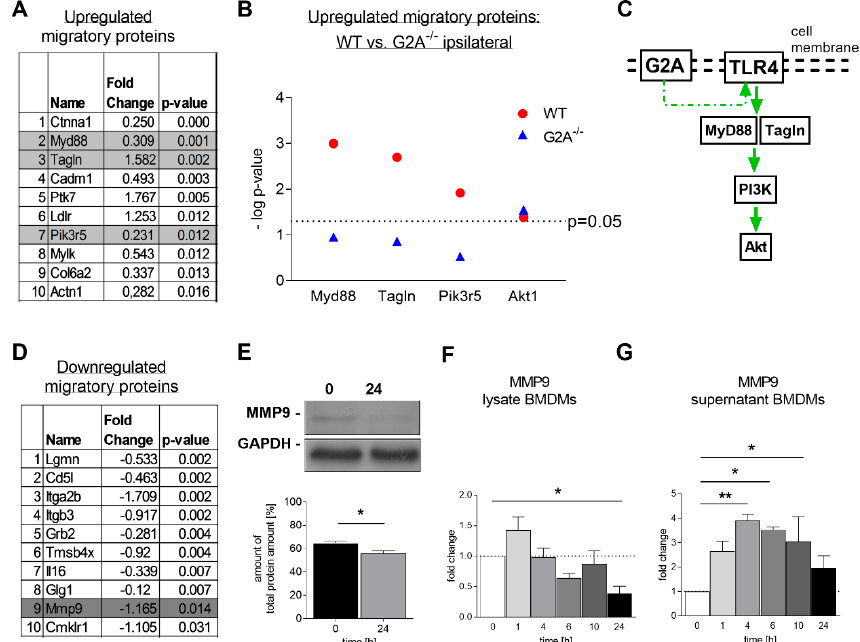
Figure 5. Transient increase of matrix-metalloproteinase 9 (MMP9) secretion and MMP9 downregulation in BMDMs 24 h after G2A activation. ( A ) List of the strongest upregulated migratory proteins in WT 24 h after 1 µ M 9-HODE stimulation. ( B ) Comparison of the strongest upregulated migratory proteins in WT and G2A-deficient (G2A − / − ) BMDMs regarding the toll-like receptor 4 (TLR4)-signaling pathway shown as -log p -value. ( C ) Scheme of possible G2A–TLR4 interaction and signaling in BMDMs. ( D ) List of the 10 strongest downregulated migratory proteins in WT 24 h after 1 µ M 9-HODE stimulation. ( E ) Representative Western Blots of MMP9 expression and respective analyzed data in untreated and treated BMDMs with 1 µ M 9-HODE. ( F ) MMP9 expression in BMDM lysates treated with 1 µ M 9-HODE for di ff erent time points. ( G ) MMP9 secretion of BMDMs treated with 1 µ M 9-HODE for di ff erent time points. Analyzed with ELISA. n = 6–10 male animals per group. Data represents mean ± SEM. * p < 0.05, ** p < 0.01. An unpaired one-tailed t -test and a One-way ANOVA were